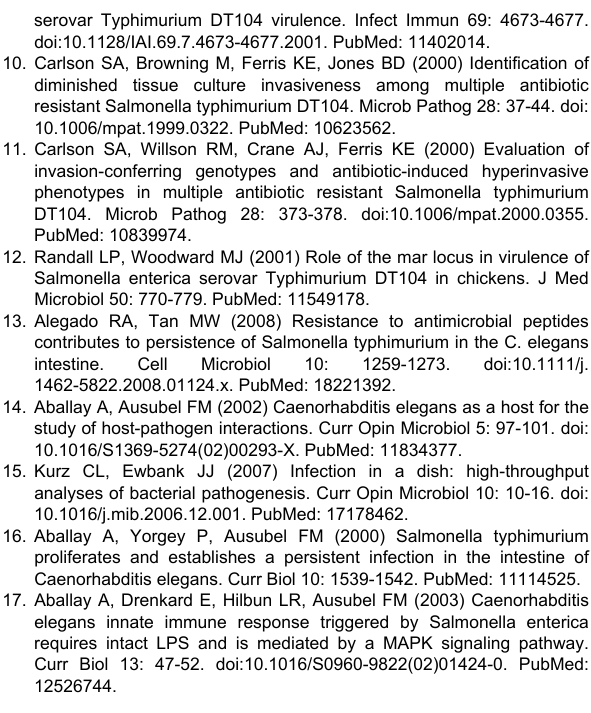
Figure S5. Ced-1 mutant C. elegans worms are more sensitive to killing by DT104. Ced-1 loss-of-function mutant worms [ ced-1 ( e1754 )] die significantly faster (P=0.0001) than